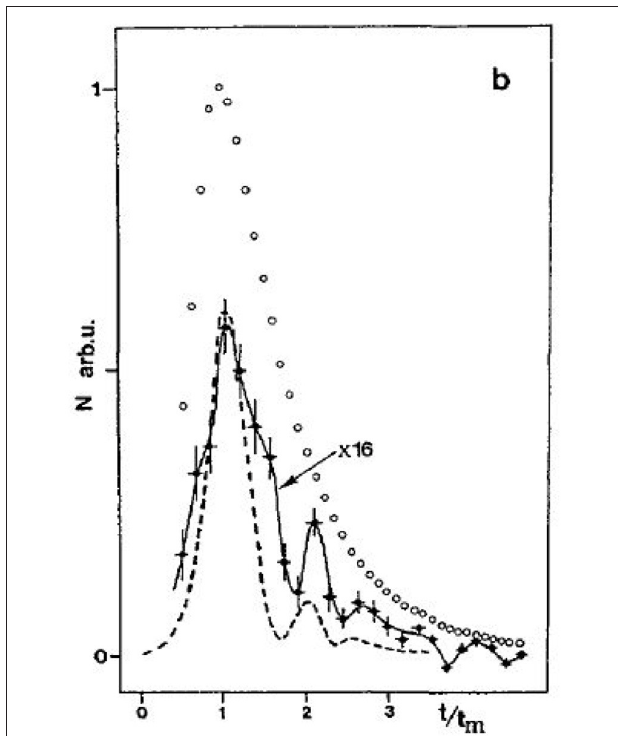
FIGURE 1 | An example of the data from Robert et al. [12]. Intensity of the emitted radiation as a function of time of flight t (in units of the most probable time of flight t m ). The dashed line is an analogous prediction for an appropriate Young-type single-photon